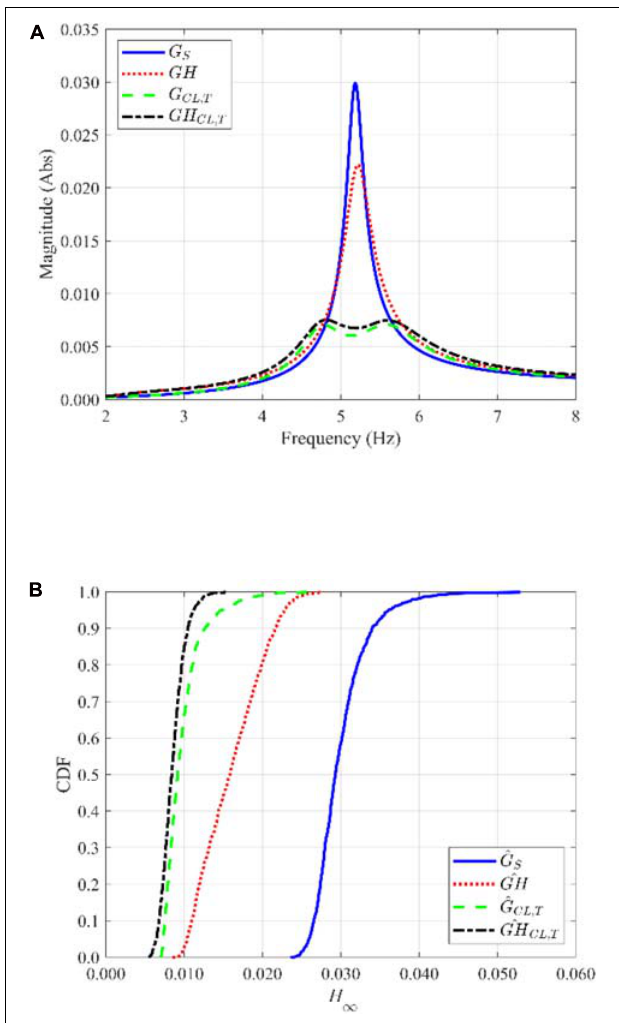
FIGURE 8 | TV A performance: (A) Magnitudes of the TFs for nominal values, and (B) CDF curves due to uncertainties in the systems.